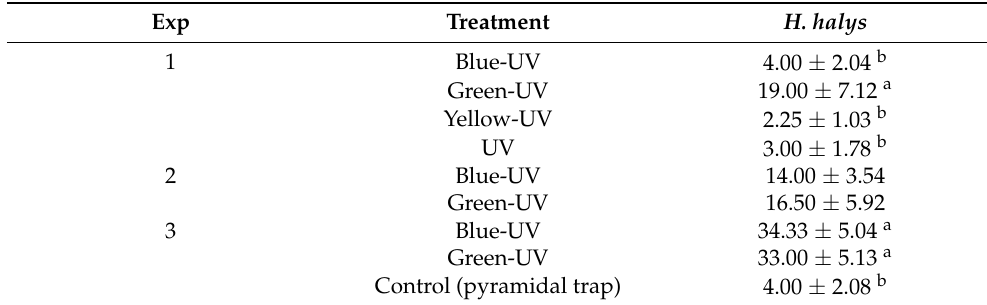
Table 2. Arrestment/presence (mean ± SE) of H. halys in the different sectors of a single multimodal trap (Exp. 1 and 2) or total H. halys (mean ± SE) captured in multimodal or control traps (Exp. 3). For each experiment, means followed by different letters are significantly different according to linear mixed-effects model followed by multiple comparisons procedure (significance level α = 0.05).